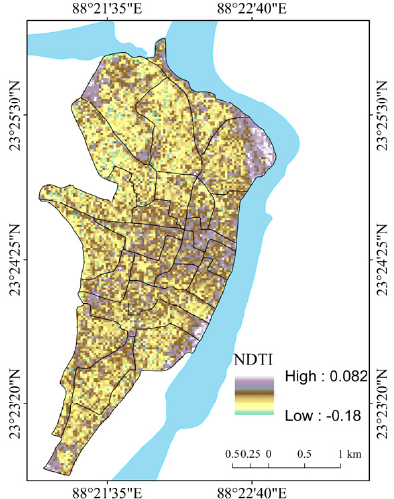
Figure 24. NDSI (2000).